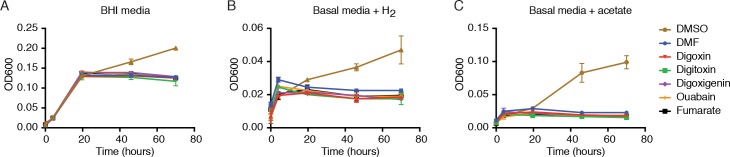
Digoxin and related cardenolides do not affect E. lenta growth in rich or minimal media.E. lenta DSM 2243 growth in (A) rich media or in basal media lacking terminal electron acceptors and including (B) 5% H2 or (C) 10 mM sodium acetate as electron donors. Cells were grown in 10 mL of media supplemented with 10 µM of each substrate or an equivalent volume (0.1% v/v) of solvent (DMSO and DMF) at 37°C. DMSO serves as a positive control to show that E. lenta is capable of anaerobic respiration. Data represents mean ± SEM (n = 3).